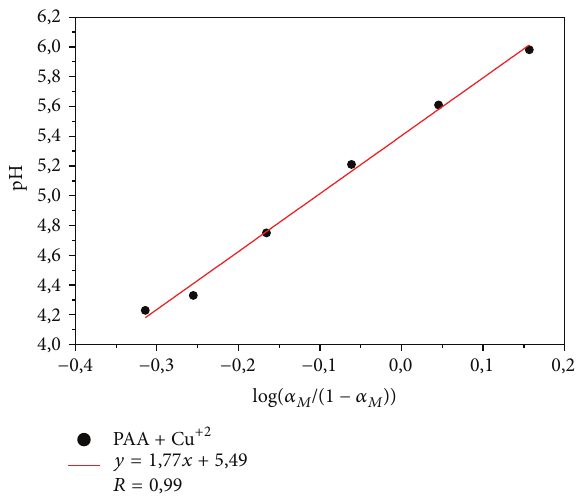
Figure 9: Plot of pH = f ( log (𝛼 𝑀 /(1 − 𝛼 𝑀 ))) for HQ-PAA/Cu(II). [NaNO 3 ] = 0.00 mol/L.